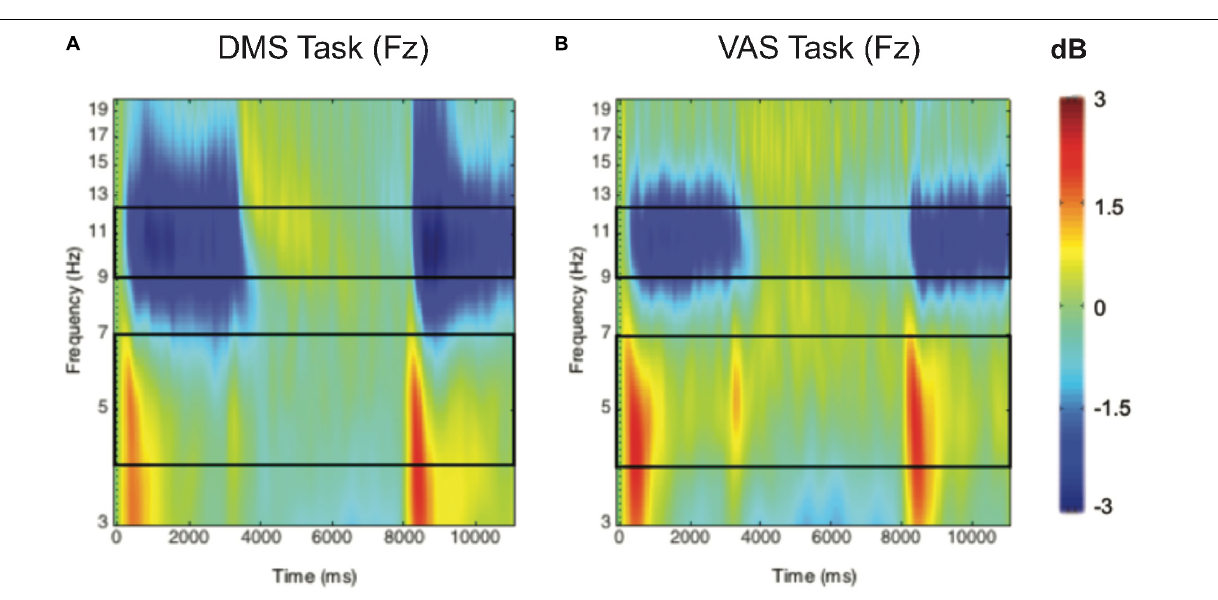
time period of interest (0–3000 ms), and then subjected